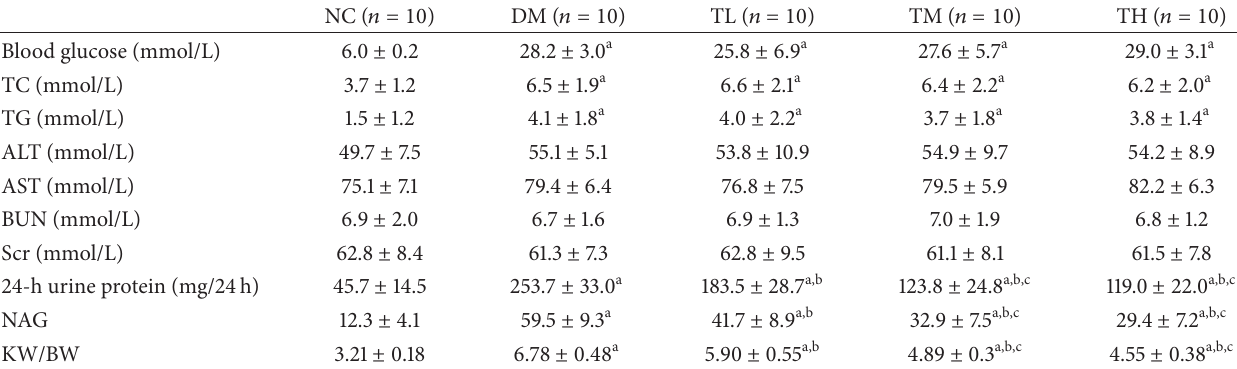
Table 1: Physical and biochemical parameters of the rats in different groups (mean ± SD).